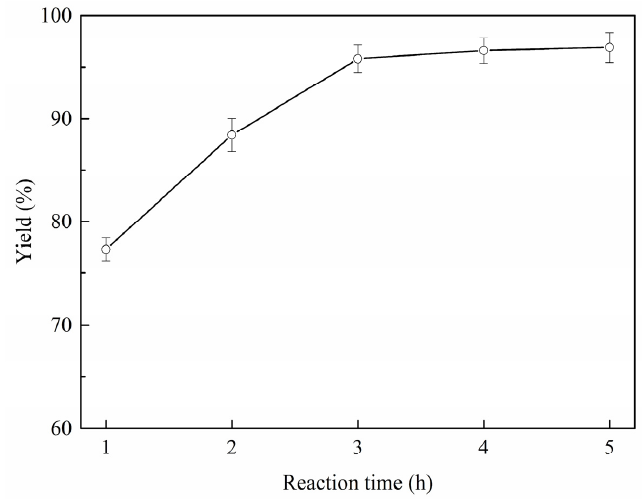
Figure 6. Effect of reaction time on the transesterification at temperature of 140 °C and methanol/oil/IL (molar ratio) of 9/1/0.25.